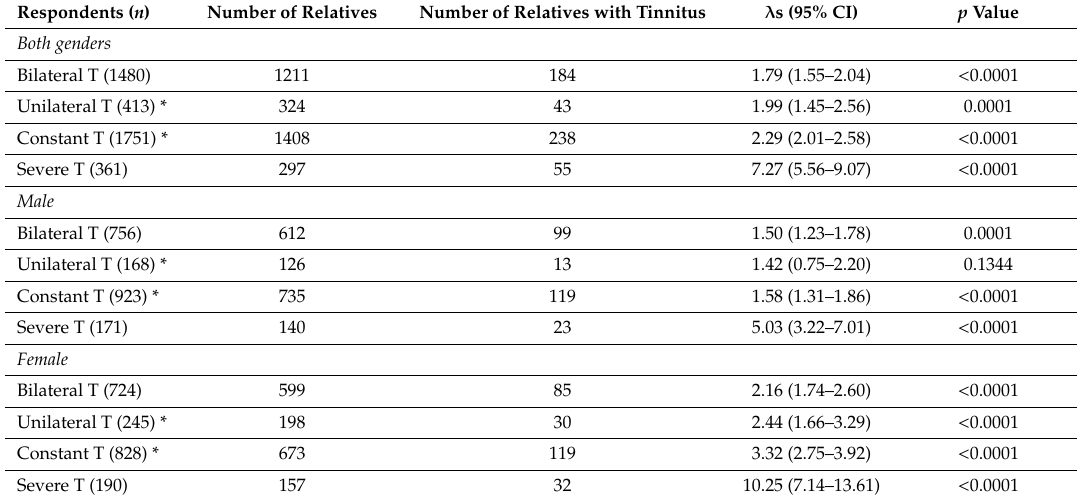
Table 2. Recurrence risk ratio ( λ s) for participants with tinnitus and a ff ected siblings. T = tinnitus. Estimates in bold are statistically significant at 0.05 level. * demarks the groups for which an artificially aged population estimate reported in Table 1 was used to calculate λ s. This procedure is detailed in Supplementary Materials